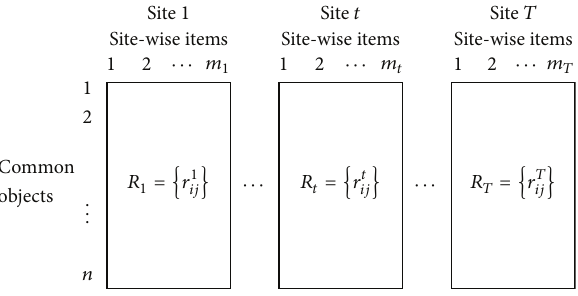
Figure 1: Vertically distributed cooccurrence